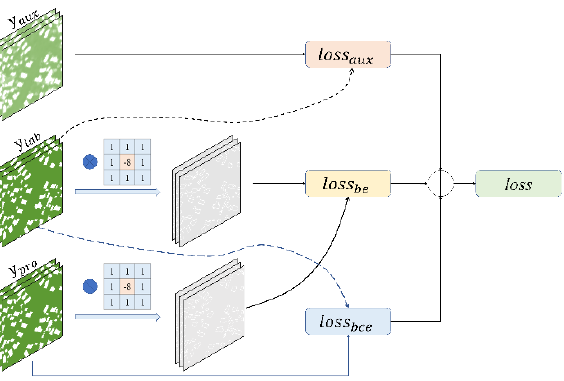
Figure 5. Flow chart of the loss function. The 3 × 3 matrix represents the Laplacian operator.